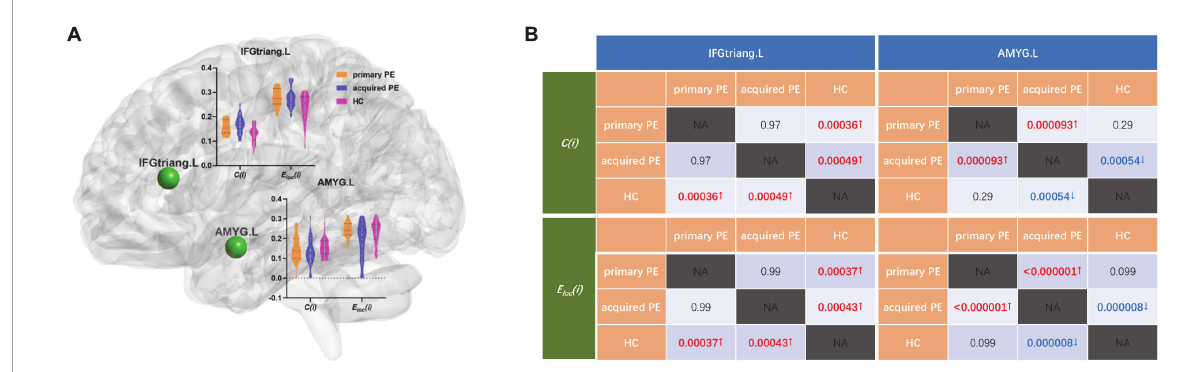
FIGURE3 Comparison of nodal segregative parameters between primary PE, acquired PE and HC groups. (A) The results of one-way analysis of variance (ANOVA) test among groups, red and black dotted lines in the violin plots represented the medians and quartiles of nodal segregative parameters; (B) the results of post-hoc contrasts by least-significant difference (LSD) test between groups. PE, premature ejaculation; HC, health controls. IFGtriang.L, left inferior frontal gyrus (triangular part); AMYG.L, left amygdala. C ( i ), the clustering coefficient of node i ; E loc ( i ), the local efficiency of node i . NA, not applicable. Red/blue P and ↑ / ↓ indicated increased/decreased nodal segregative parameters obtained from the comparisons between primary PE vs. HC; acquired PE vs. HC and primary PE vs. acquired PE. P < 0.05 indicated statistically significant